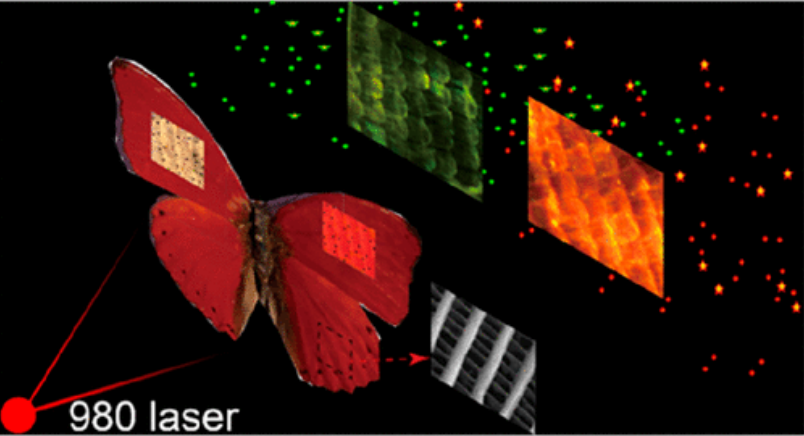
Figure 9. The upconversion luminescence of nanoparticles doped with lanthanide (NaYF 4 : Yb 3 + ,Er 3 + ) was controlled thanks to the natural photonic crystals occurring in the wings of the butterfly Cymothoe sangaris . With a 980 nm incident light, various luminescent colours were generated. Reproduced from Gao, T., Zhu, X., Wu, X. J., Zhang, B., and Liu, H. L., 2021, Selectively Manipulating Upconversion Emission Channels with Tunable Biological Photonic Crystals, J. Phys. Chem. C, 125(1), 732–739, with permission from ACS